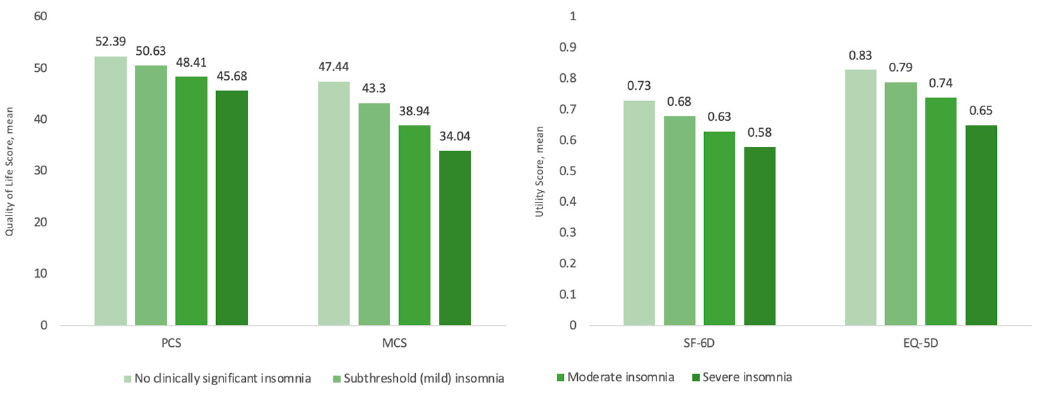
Figure 1. Adjusted utility values by insomnia severity category. Abbreviations: EQ-5D, EuroQol-5D; MCS, mental component summary; PCS, physical component summary; SF-6D, Short Form-6 Di- mensions.